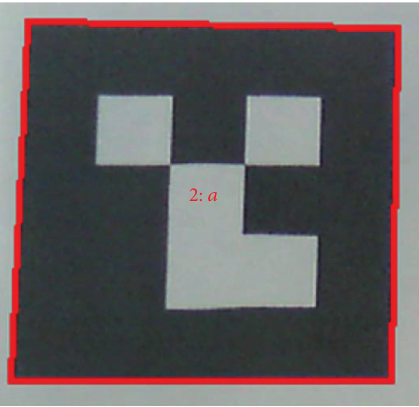
Figure 4: Marker detection.